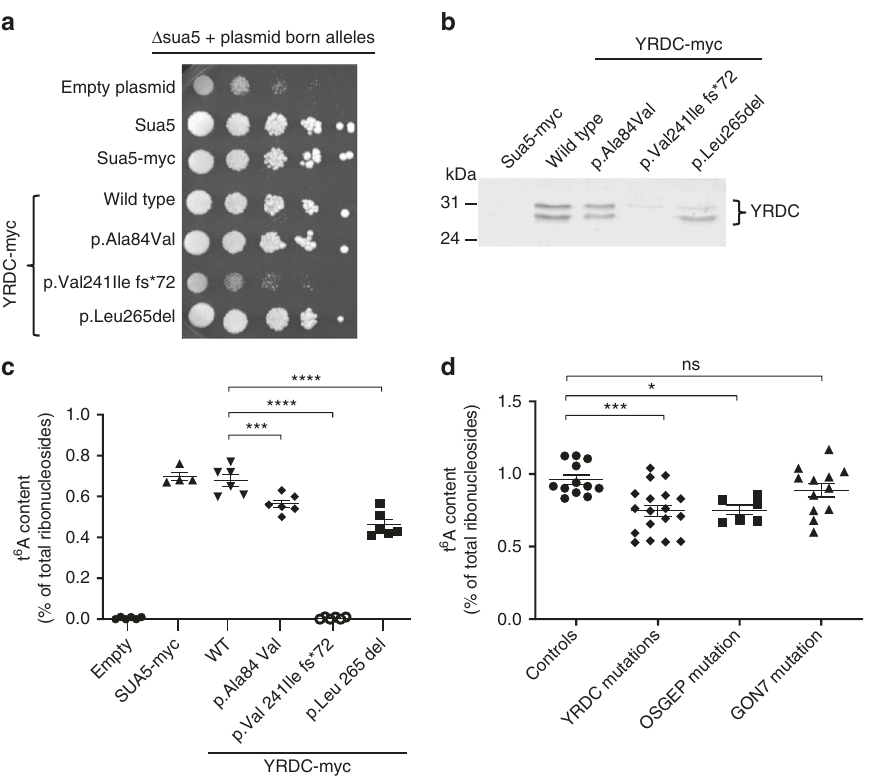
Fig. 3 Effects of YRDC and GON7 mutations on t 6 A biosynthesis. a Evaluation of fi tness of Δ sua5 yeast strains expressing human YRDC variants (spots are from 10-fold serial dilutions of cell suspensions at OD 600nm = 0.5, and three independent clones were evaluated) and b western blot analysis on total protein extracts from Δ sua5 yeast cells expressing human YRDC variants using anti-hYRDC antibody. c , d Mass spectrometry (LC-MS/MS) quanti fi cation of t 6 A modi fi cation in total tRNAs extracted from Δ sua5 yeast cells expressing human YRDC variants ( c ) (mean ± s.e.m. of two independent LC-MS/MS experiments (technical replicates), each measuring samples from three independent yeast transformants; one-way ANOVA ( F (5,28) = 269.4, p < 0.0001), Dunnett ’ s multiple comparisons test, *** p = 0.0008, **** p < 0.0001) and from cultured primary skin fi broblasts from controls (two unaffected individuals) and affected individuals with either the p.Tyr7* GON7 mutation (two individuals), or the YRDC mutations (three individuals) or with the p. Arg352Gln OSGEP mutation in the homozygous state (individual «CP» described in Braun et al. 13 ) ( d ) (mean ± s.e.m. of two independent LC-MS/MS experiments (technical replicates), each measuring samples from three independent cell culture experiments; one-way ANOVA ( F (3,44) = 6.446, p < 0.001), Dunnett ’ s multiple comparisons test, n.s. = 0.4894, * p = 0.0169, *** p = 0.008). Source data are provided as a Source Data fi